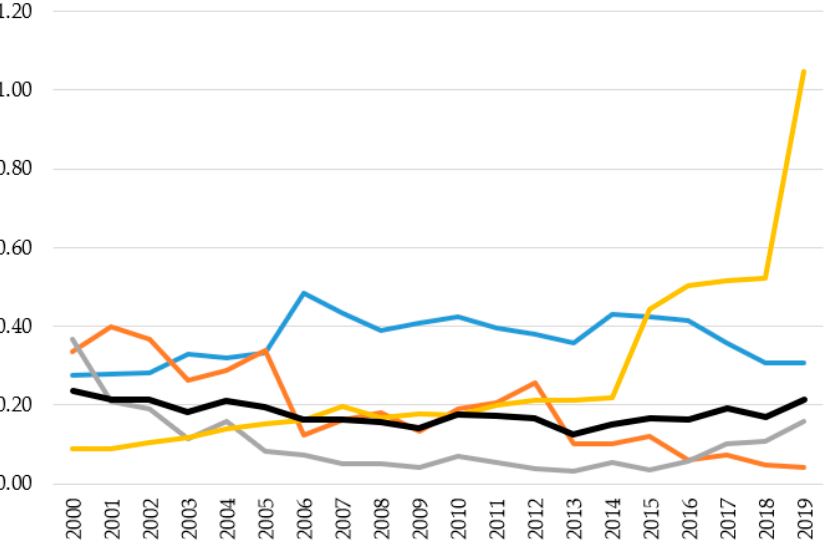
Figure 16. Dynamics of the structural components of the index of economic security in Germany: blue line–social security index, orange–industrial and service security index, grey–financial and macroeconomic security index, yellow–resource index, and black–economic security index.